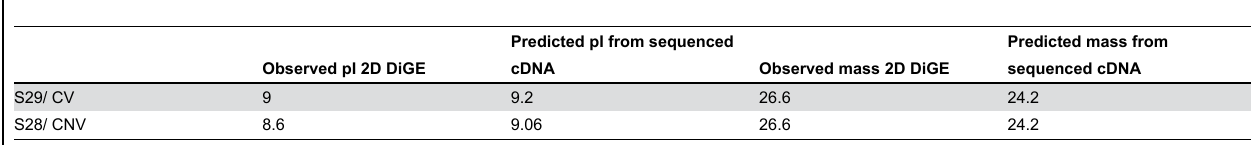
Table 1. Comparison of the observed and the predicted pI and molecular mass for both cyclophilin